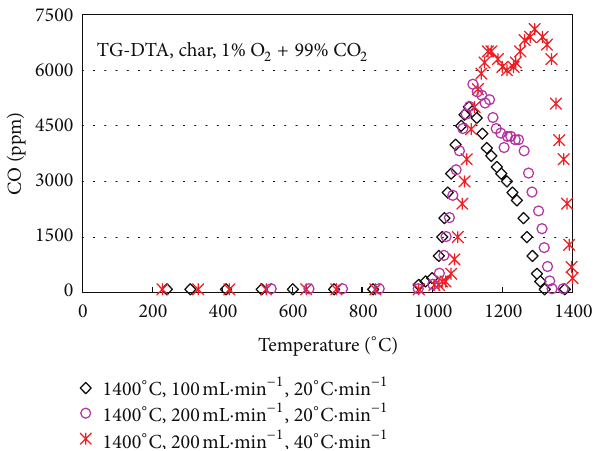
Figure 28: Cumulative HCs gas versus O 2 % for different tempera- ture gradients during 20 to 700 ∘ C (0 to 35 min).